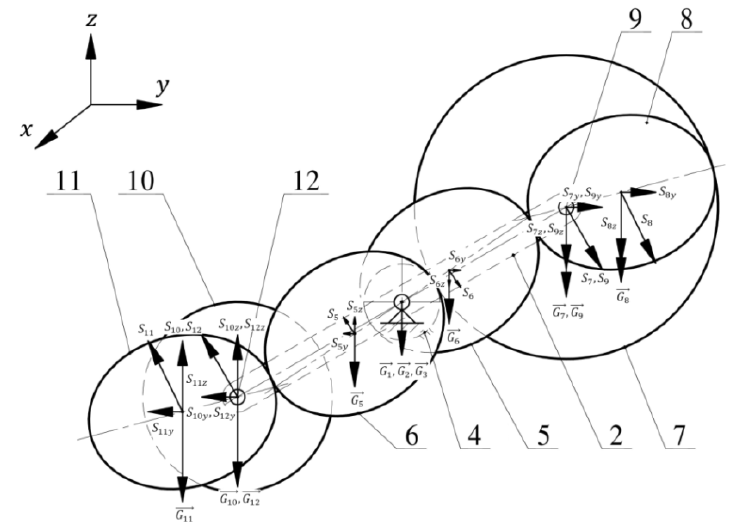
Figure 5. Scheme for determining works of the gravity forces.